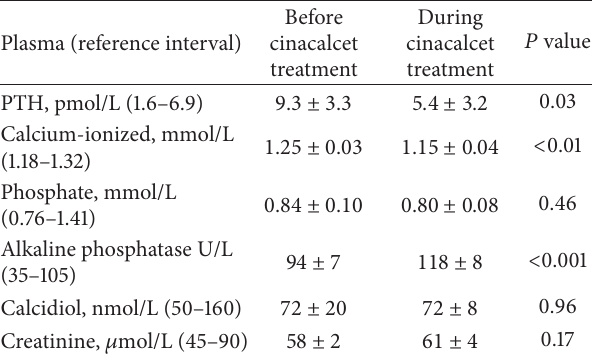
Table 1: Effect of cinacalcet treatment on biochemical indices of cal- cium homeostasis in a patient with X-linked dominant hypophos- phatemia. Before Plasma (reference interval)